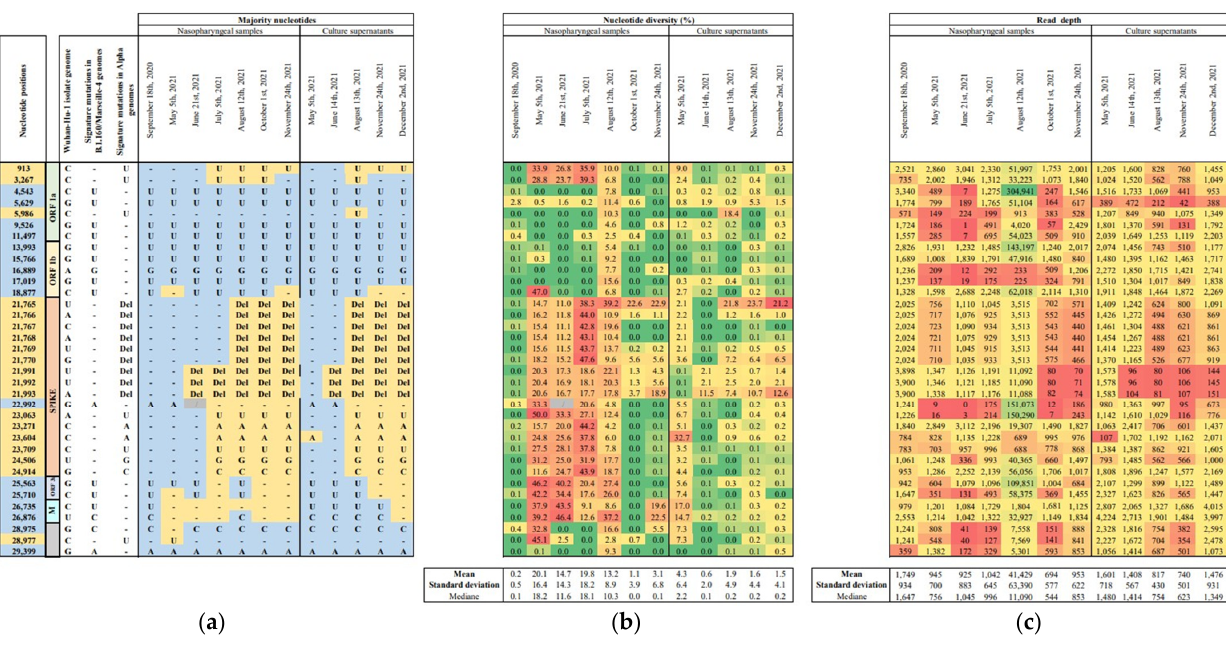
Figure 2. Majority nucleotides ( a ) nucleotide diversity ( b ) and sequencing depth ( c ) for sequences obtained from the respiratory samples and the culture supernatant at nucleotide positions of the SARS-CoV-2 genome that harbor signature mutations of the B.1.160 or Alpha variants. Del, nucleotide deletion. Nucleotide positions are in reference to the genome of the Wuhan-Hu-1 isolate GenBank accession no. NC_045512.2. ( b ) Nucleotide diversity is the proportion of sequence reads that do not harbor the consensus (majority) nucleotide. ( c ) Read depth is the number of reads covering a given nucleotide position.